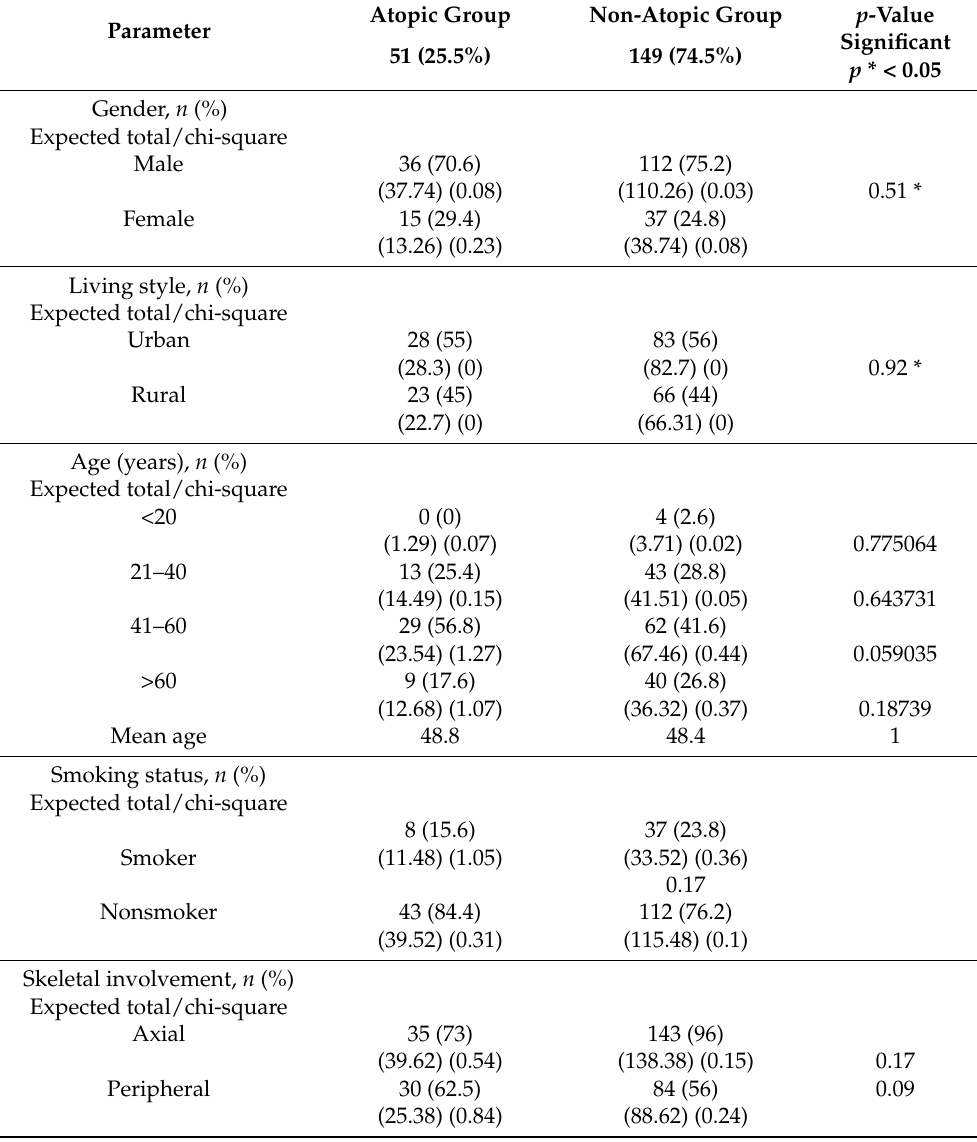
Figure 2. Distribution of atopic disorders among SpA with atopy ( a ) and SpA with current atopy ( b ) (AR, atopic rhinitis; AD, atopic dermatitis; AA, allergic asthma). Table 3. Characteristics of atopic and non-atopic patients. Atopic Group Non-Atopic Group p Parameter